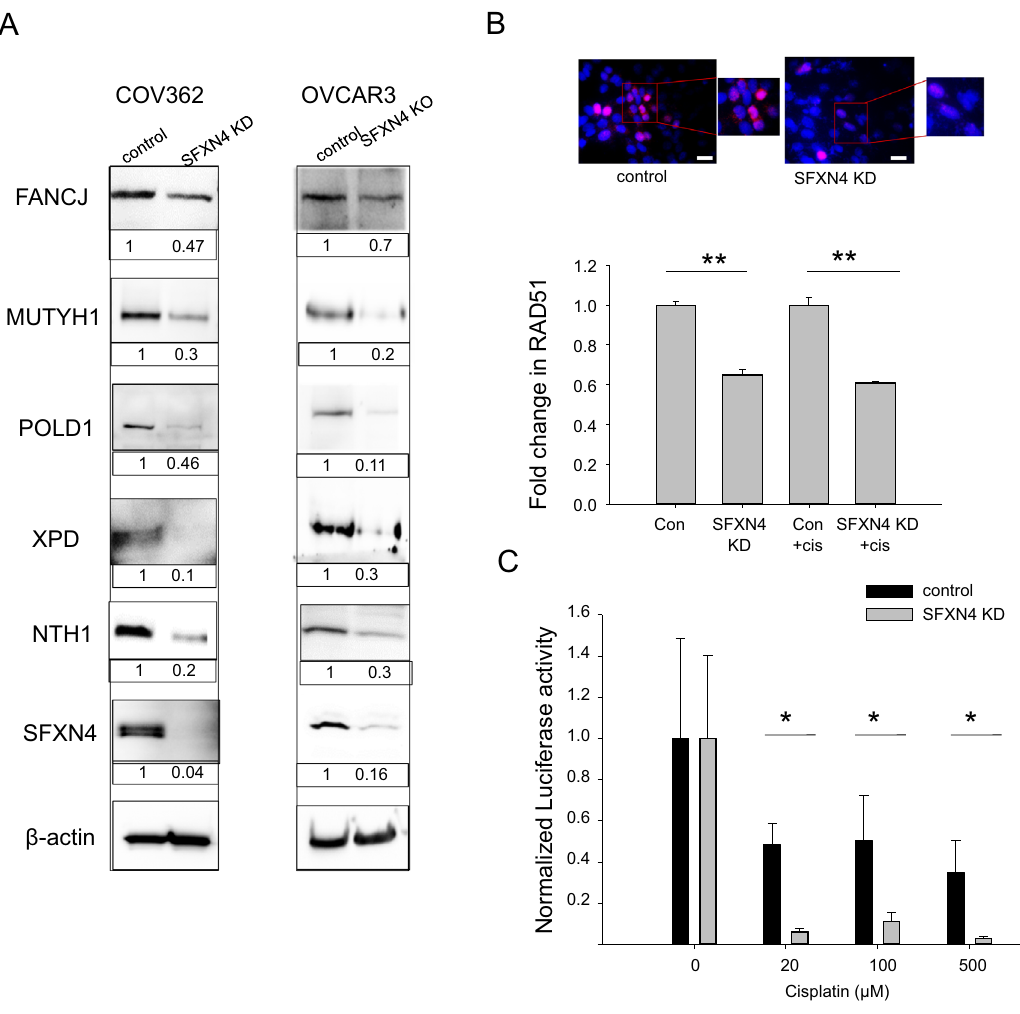
Figure 4. SFXN4 KD decreases Fe-S containing DNA repair proteins, RAD51, and DNA repair capacity. ( A ) Western blot of Fe-S containing DNA repair proteins in control and SFXN4 knock-down ovarian cancer cells (siRNA was used to knock down SFXN4 in COV362 cells and CRISPER/Cas was used to knockout SFXN4 KO in OVCAR3 cells). Uncropped images are presented in Supplemental data (Supplemental Figs. S11, S12). ( B ) Representative immunofluorescence image of RAD51 foci (red) in siRNA SFXN4 knock-down and siRNA control COV362 cells (nuclei were stained with DAPI) and quantification of fold change in RAD51 foci in SFXN4 knockdown versus control cells treated without or with 20 µM cisplatin for 48 h (means and standard deviations, **p < 6.4E−05). Scalebar is 10 µm. ( C ) DNA repair capacity as measured by dual luciferase assay in siRNA control and siSFXN4 COV362 cells transfected with undamaged or cisplatin damaged luciferase plasmid for 24 h. Shown are means and standard deviations of 3 independent experiments, each with 4 replicas (*p <